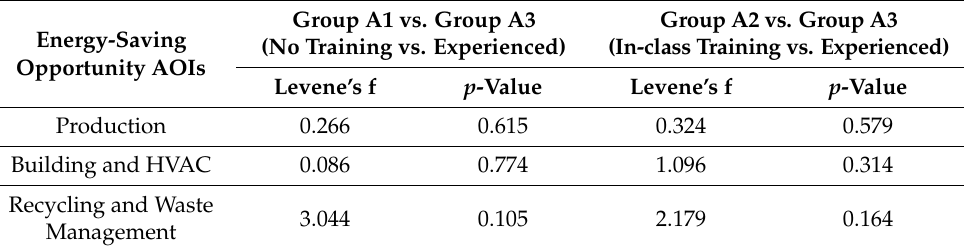
Table 6. Levene’s test results for homogeneity of variances across the